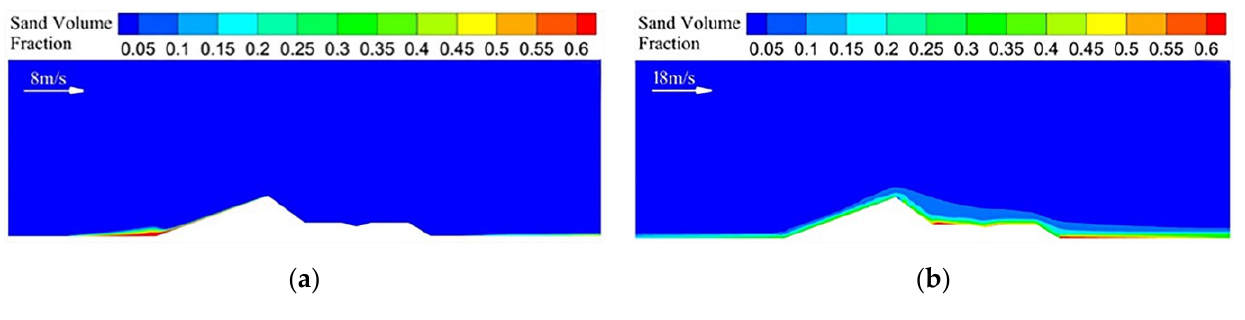
Figure 13. Distribution of sand volume fraction around embankment on the dune’s windward side ( a )Wind speed of 8 m /s ( b )Wind speed of 18 m /s.